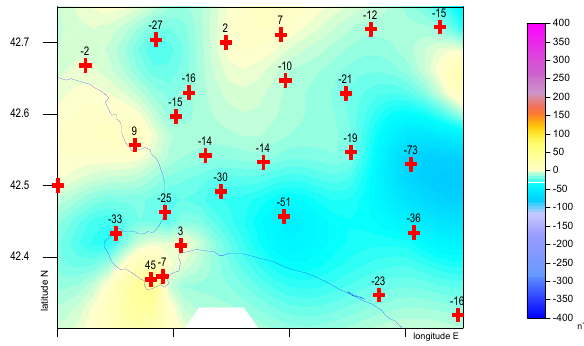
Figure 5. New total intensity anomaly map over Albegna Basin: crosses indicate the onshore stations by Italian database now cor- rected.